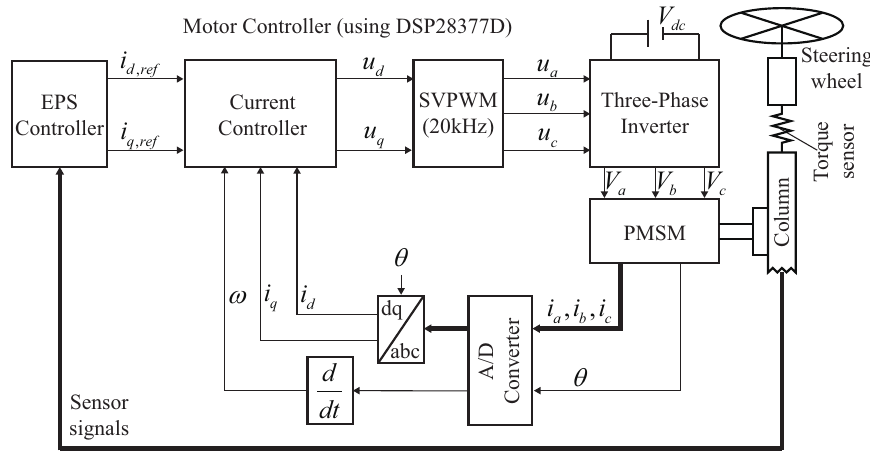
Figure 12. Configuration of implemented closed-loop system